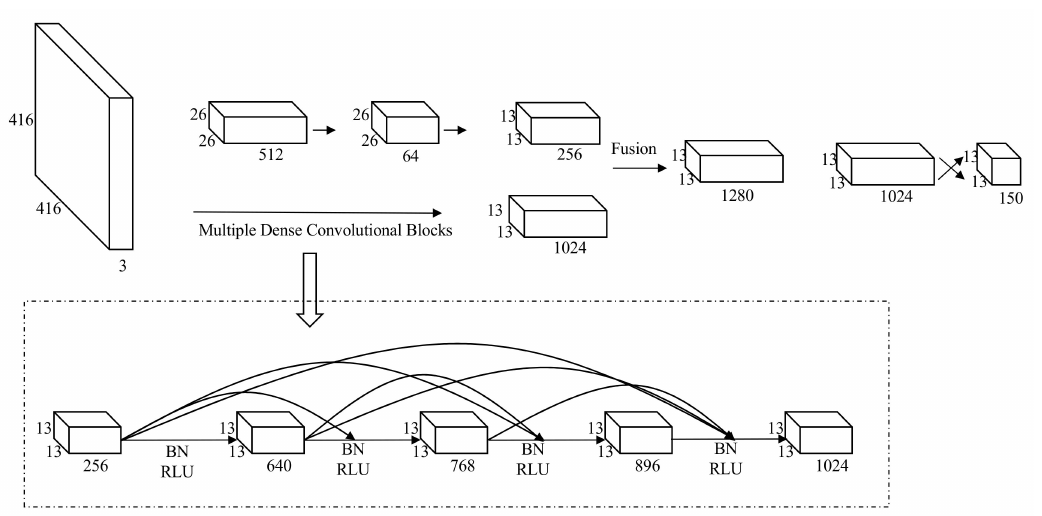
Figure 5. Scene segmentation graphs obtained by di ff erent algorithms. RLU: rectified linear units and BN: